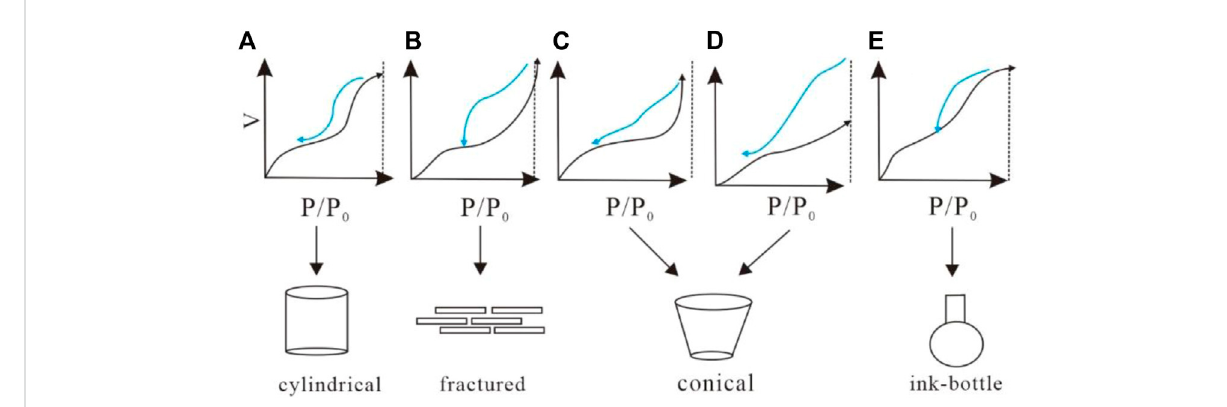
FIGURE 4 Relationship between the hysteresis loop and pore morphology.